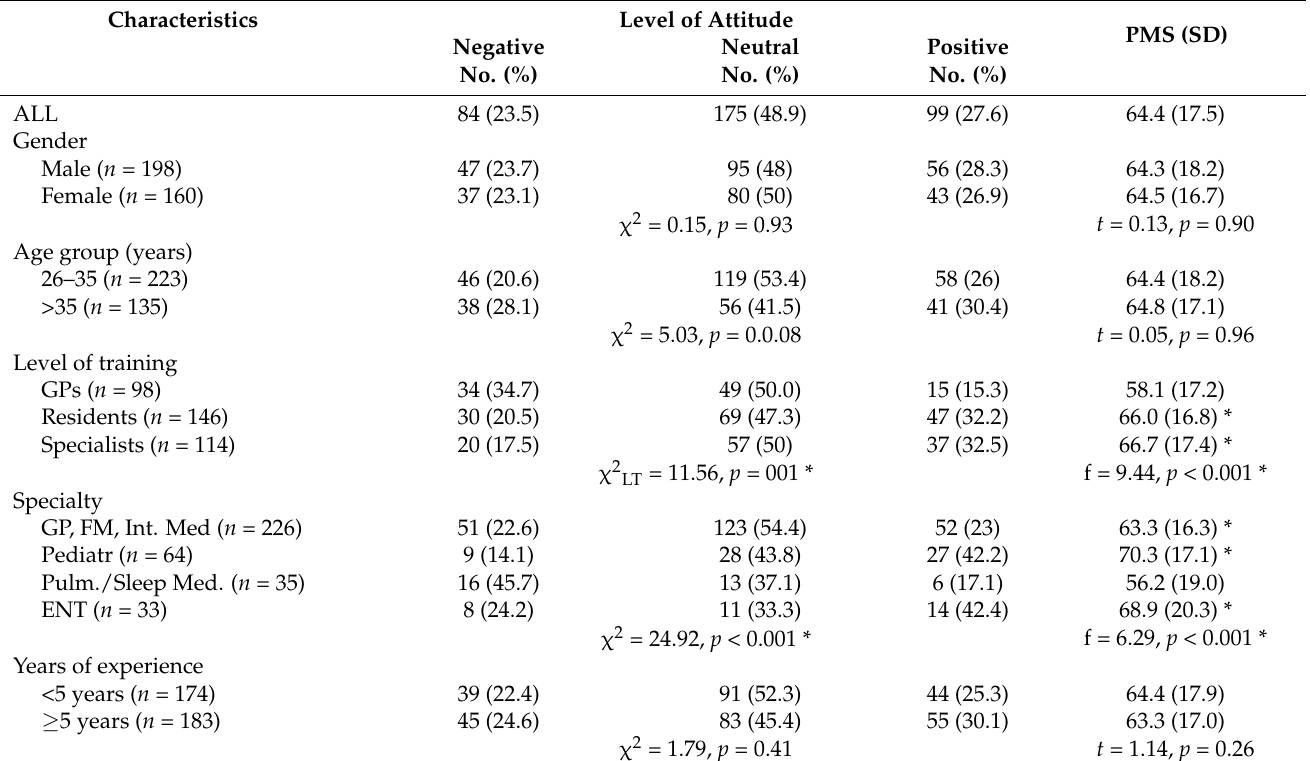
Table 5. Attitude of physicians towards the role of dentists in OSA management according to some personal